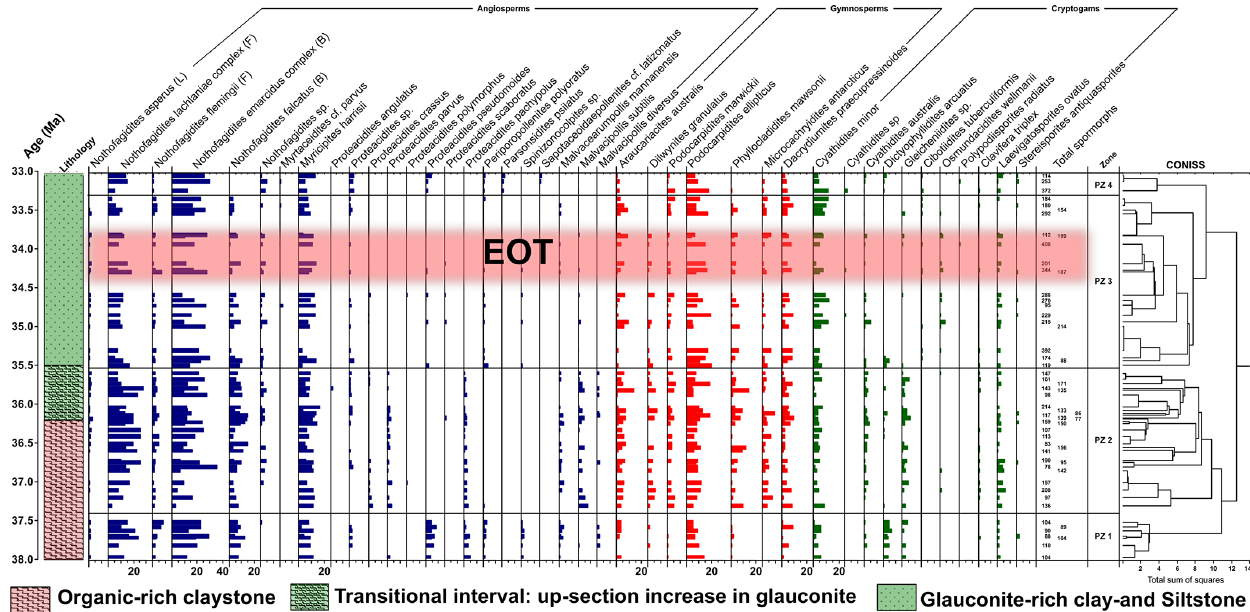
Figure 2. Sporomorph assemblages and relative abundances of major sporomorph taxa (angiosperms, gymnosperms, cryptogams) recovered from the late Eocene–early Oligocene of ODP Site 1172. Angiosperm relative abundances are marked by blue bars, gymnosperm relative abundances by red bars, and cryptogam relative abundances by green bars. In the angiosperm group, Nothofagidites is further divided into subgenera. These are Brassospora (B), Fuscospora (F), and Lophozonia (L) types. CONISS ordination constrains our late Eocene–early Oligocene sporomorph assemblages into four distinct pollen zones (PZ 1–PZ 4) or vegetation and climate phases. The age model is after Houben et al. (2019) and Bijl et al.